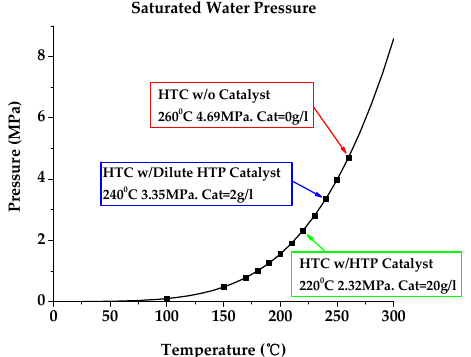
Figure 1. Saturated water pressure as a function of temperature over the region from 100 to 260 °C. The data points were calculated from the EFUNDA online publisher of saturated steam tables [13]. Fine chips (wood) used for feedstock.